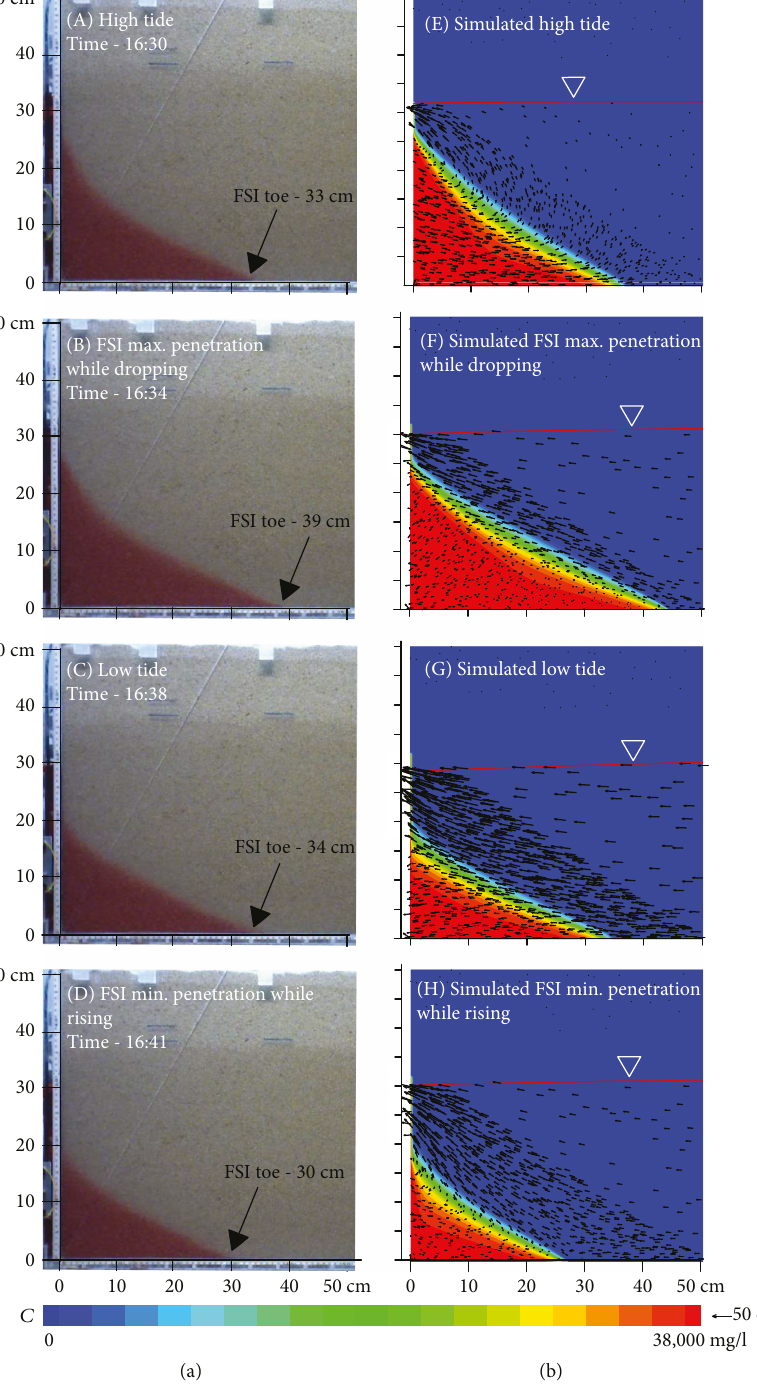
Figure 4: Four stages of a typical sinusoidal wave, each includes a snapshot of the laboratory experiment at A and the appropriate modeling result at B. Black arrows at the modeling snapshots represent the velocity